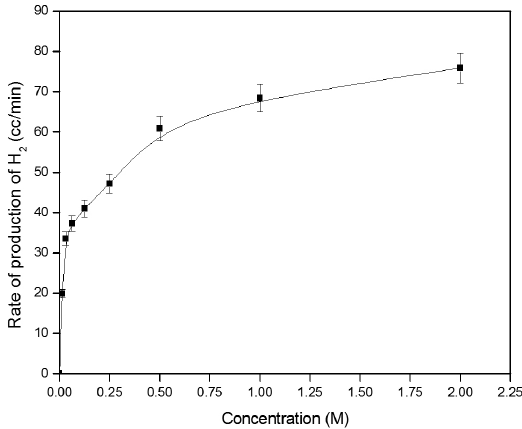
Figure 2. Effect of electrolyte concentration on the production of hydrogen gas: Reaction conditions: Dimensional of graphite rod: 80 × 20mm; Temperature: 303 K; Pressure: 1 atm; Applied voltage: 12 V; Applied Current: 1.2 A; Reaction Time: 10 mts and Distance between the electrodes: 2